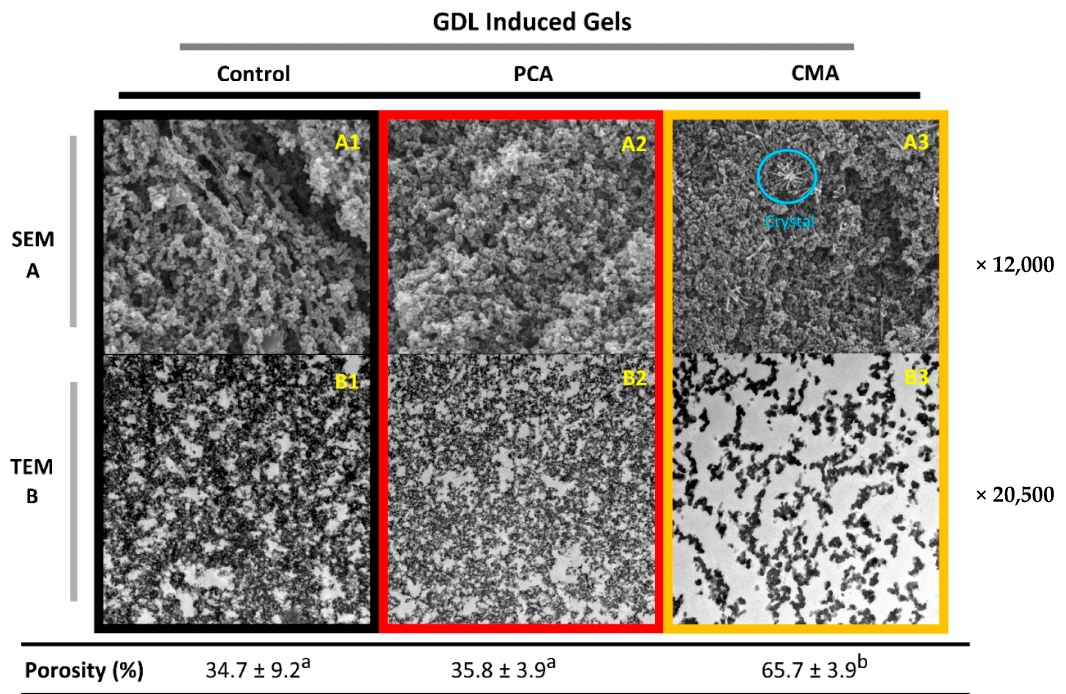
Figure 2. Microstructural characteristics of soy protein pressed gels induced by GDL. The SEM micrographs were presented on the ( A ) row and the TEM micrographs on the ( B ) row. GDL-induced gels without the addition of bioactives ( A1 , B1 ), gels with added PCA ( A2 , B2 ) and CMA ( A3 , B3 ). The values of porosity were represented as means ± standard deviations ( n = 20). Different letters indicate significant differences ( p ≤ 0.05).